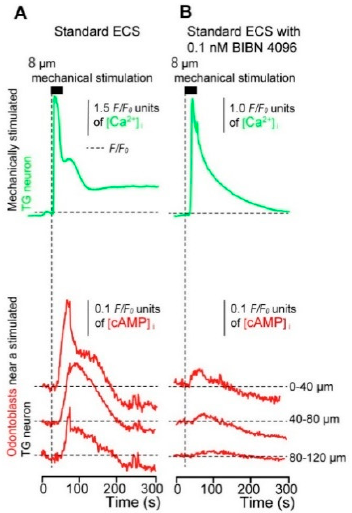
Figure 4. CGRP increases the intracellular cAMP level ([cAMP] i ). ( A , C ) Representative traces of the transient [cAMP] I level increases in response to 50 nM CGRP (rat) with or without 0.1 nM BIBN 4096 ( A ) or 0.1 μM SQ22536 ( C ) in the presence of extracellular Ca 2+ (2.5 mM) (white boxes at the bottom). Black boxes indicate the time periods of CGRP (rat) application to the extracellular solution. White boxes at the top indicate the time of addition of BIBN 4096 ( A ) or SQ22536 ( C ) to the extracellular solution. ( B , D ) Summary bar graphs show CGRP (rat)-induced [cAMP] i level increases in the control (upper column) or with (middle column) 0.1 nM BIBN 4096 ( B ) or 0.1μM SQ22536 ( D ) in the presence of extracellular Ca 2+ (2.5 mM). Each recovery effect (lower column in B , D ) shows the reversible effect of BIBN 4096 ( B ) and SQ22536 ( D ). Each bar denotes the mean ± SE. Numbers in parentheses show the number of experiments. Asterisks denote statistically significant differences between columns (shown by solid lines): * p < 0.05.